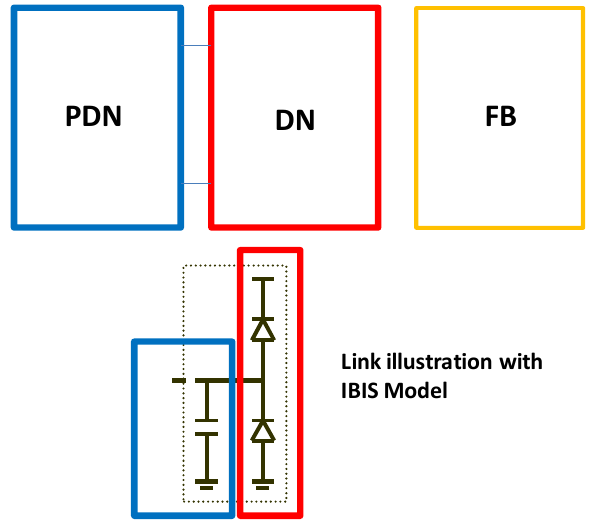
Figure 4: Generic structure of the model proposed.